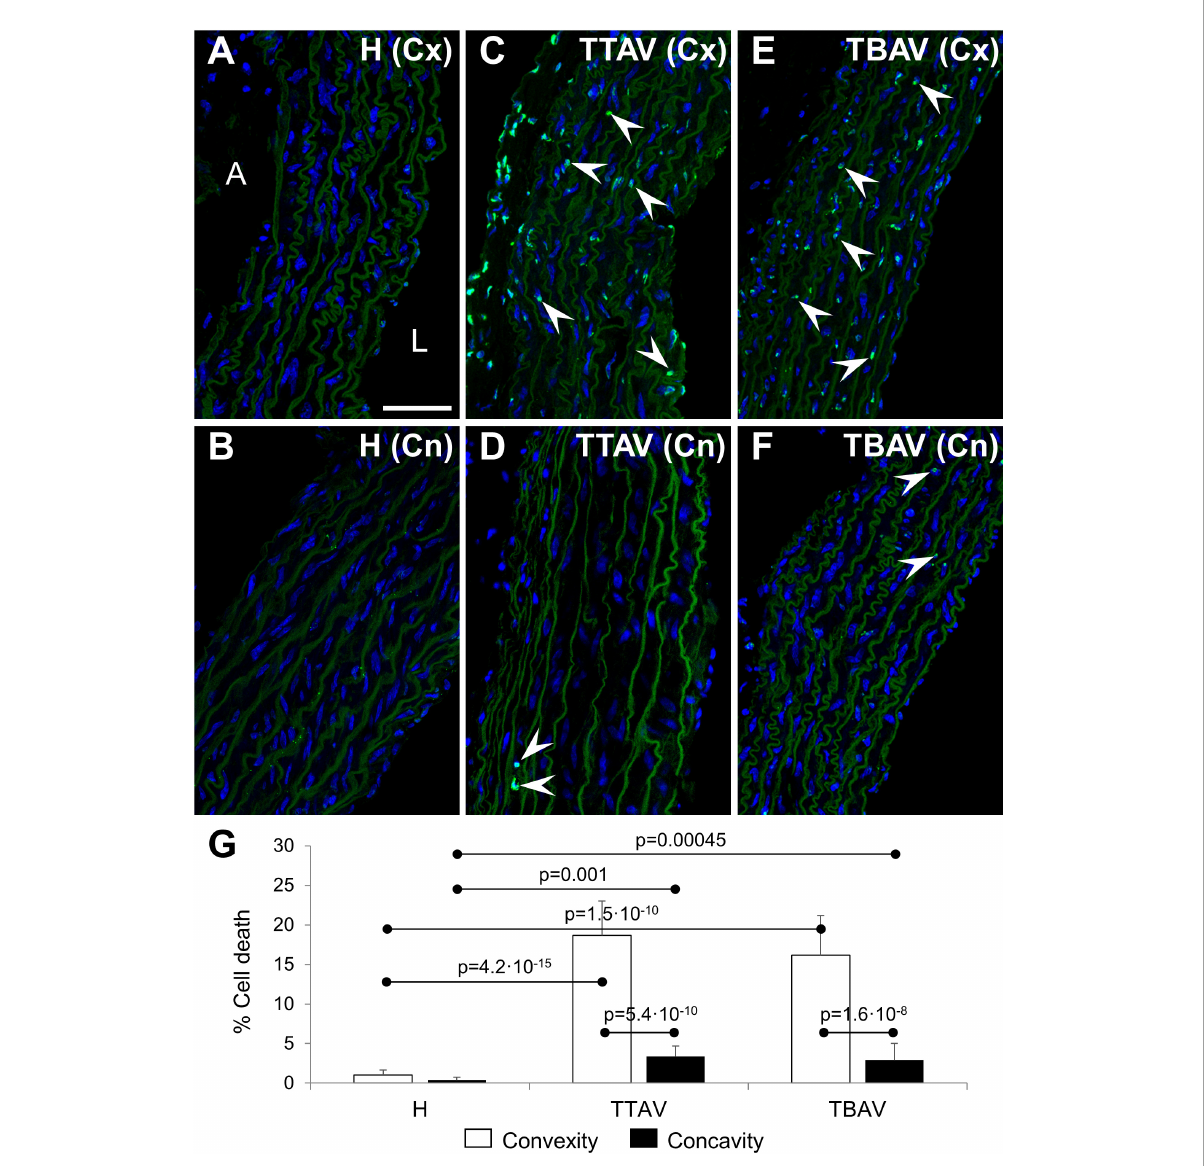
FIGURE3 Confocal images of the convexity (Cx; A,C,E ) and concavity (Cn; B,D,F ) of the ascending aorta of hamsters from the control (A,B) and affected (C–F) strains. TUNEL fluorescence (green) demonstrated abundant apoptotic cells (arrowheads) in the media of the aortic convexity of animals of the affected strain both with TAV (C) and BAV (E) . DAPI (blue) stained nuclei. No TUNEL signal was detected in aortas from control animals (A,B) and in the negative control (not shown), and only a few signals were found in the concavity of animals of the affected strain (D,F) . Note that the elastic sheets show some autofluorescence. A, adventitia; L, lumen. Scale bar: 50 µ m. (G) Quantification of the percentage of TUNEL + cells revealed significant differences between convexity and concavity, and between the affected and control strains, irrespective of aortic valve morphology. H, control strain; TBAV, bicuspid aortic valve from the affected strain; TTAV, tricuspid aortic valve from the affected strain. Only significant p -values are